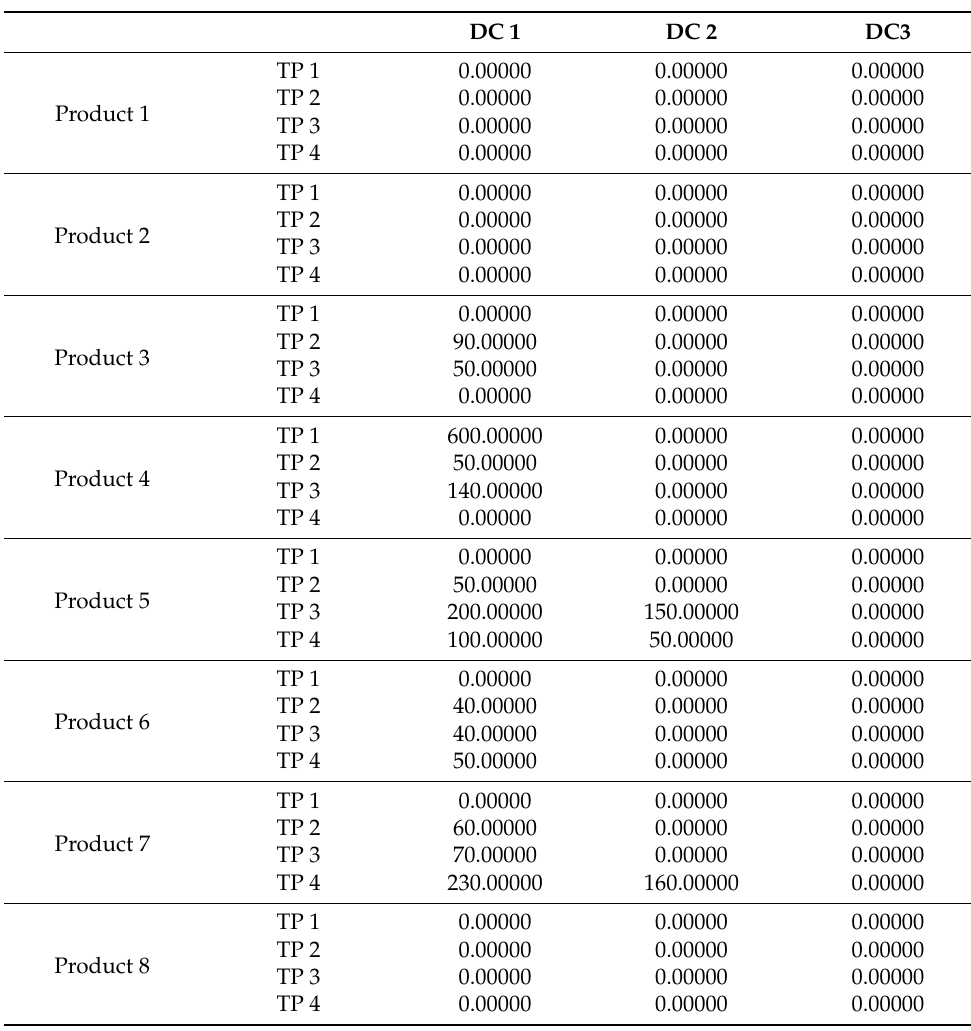
Table 14. Amount of each fish production to be kept at each time period (TP) in each of the center of (cid:16) (cid:17) I l distribution jt